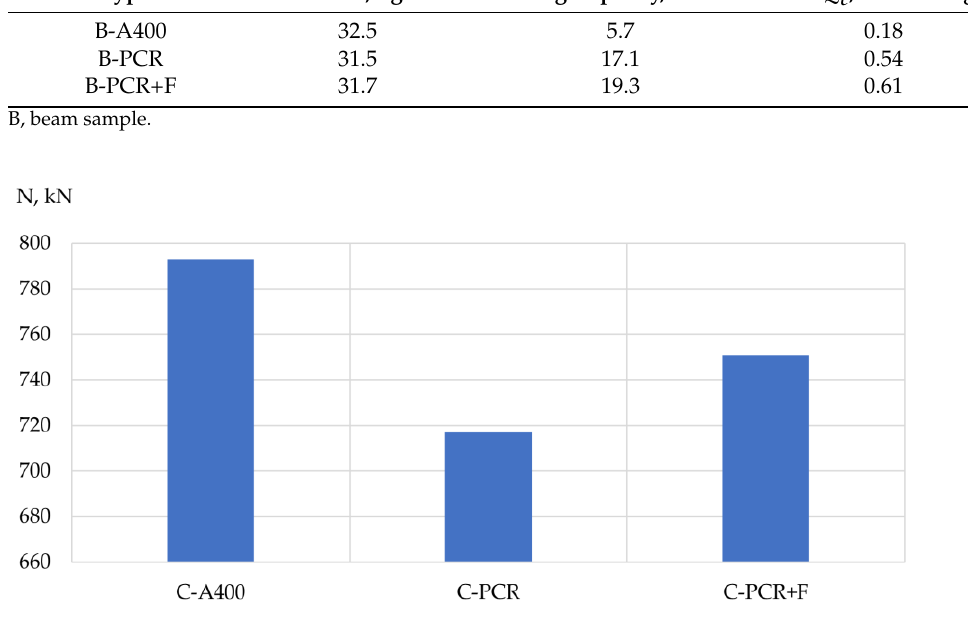
Figure 6. Dependence of the bearing capacity of the column specimens on the type of reinforcement used: C-A400 is a column specimen reinforced with A400 steel reinforcement; C-PCR is a column specimen reinforced with polymer composite reinforcement; C-PCR+F is a column specimen reinforced with polymer composite reinforcement and glass fiber.